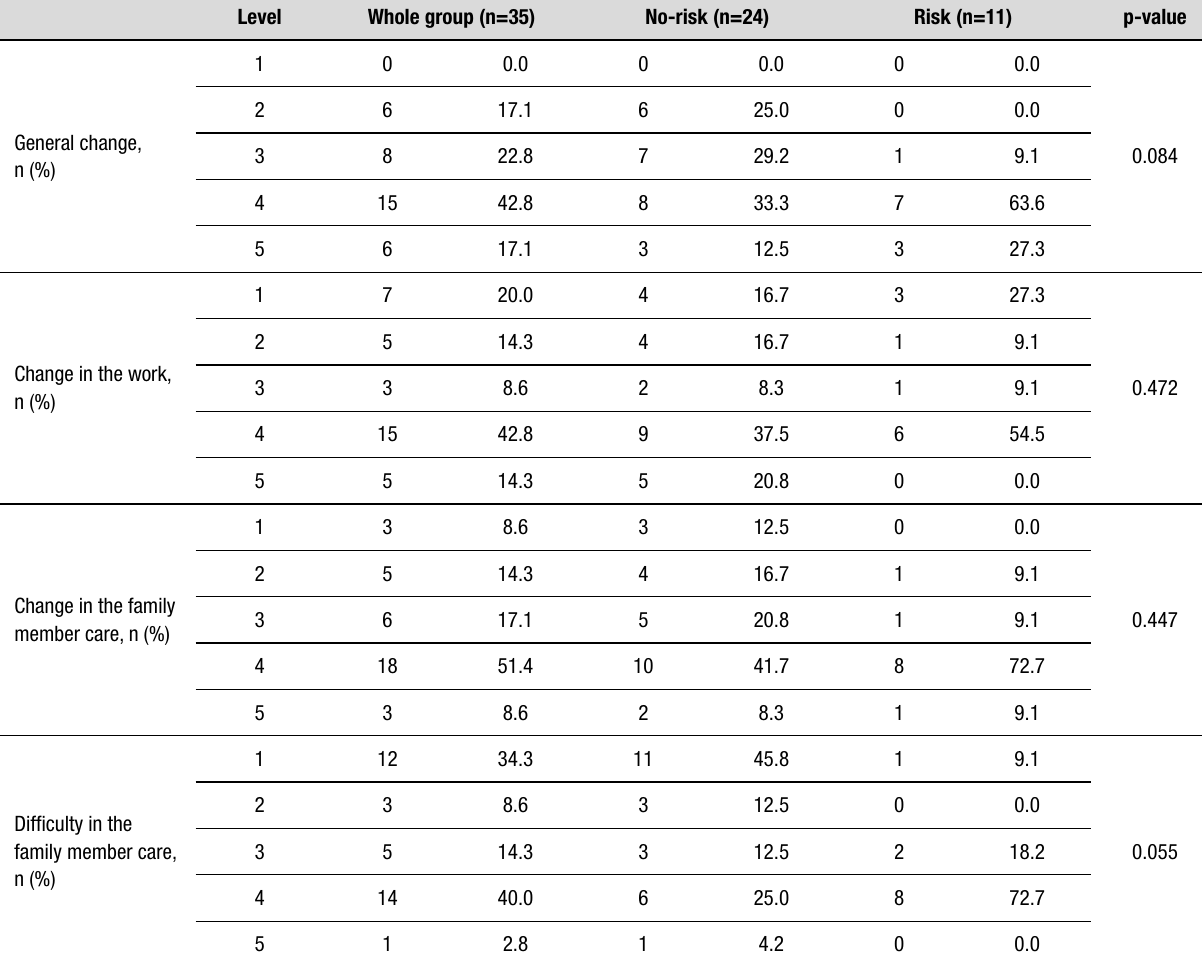
Table 3. Variables relating to the change of routine to the whole group and according to the risk classification defined by the SRQ-20 instrument (No-Risk and Risk for mental health).